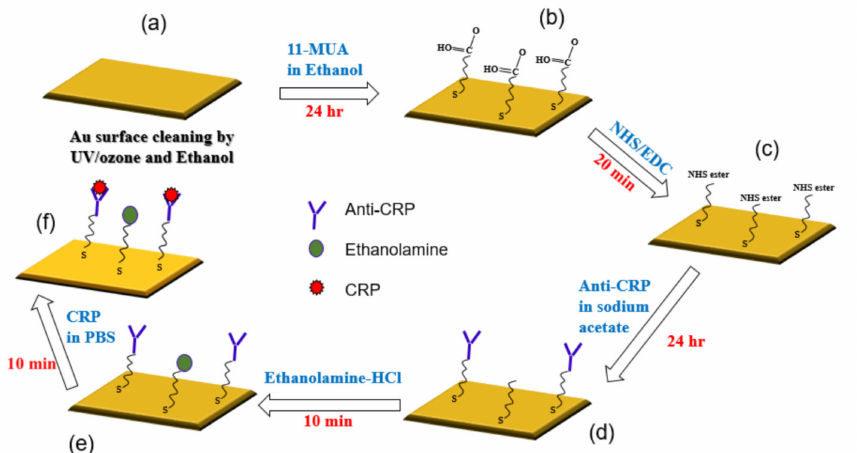
Figure 3. Schematic representation of C-reactive protein (CRP) and anti-CRP interaction process: ( a ) Au surface cleaning; ( b ) Self-assembled monolayer (SAM) on Au surface; ( c ) Activation of SAM; ( d ) Immobilization of anti-CRP; ( e ) Blocking the remaining non-specific binding of antibody active sites; ( f ) Evaluating the interaction between CRP and anti-CRP.